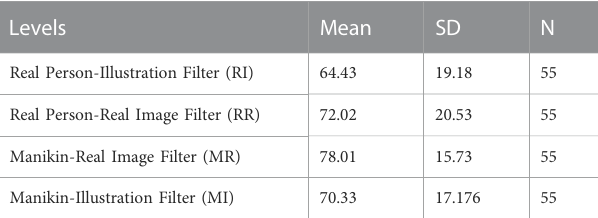
TABLE 6 Example responses regarding skin